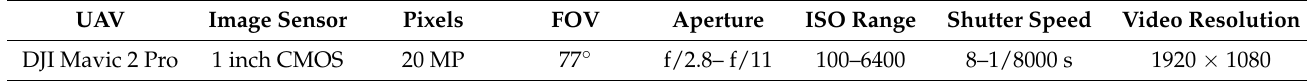
Figure 6. Image dataset. Video 1 contains an Align 700L V2 obstacle object, Video 2 contains a DJI F450 obstacle object, and Video 3 contains a DJI Mavic 2 Pro obstacle object. Table 1. Camera properties of the other DJI Mavic 2 Pro.